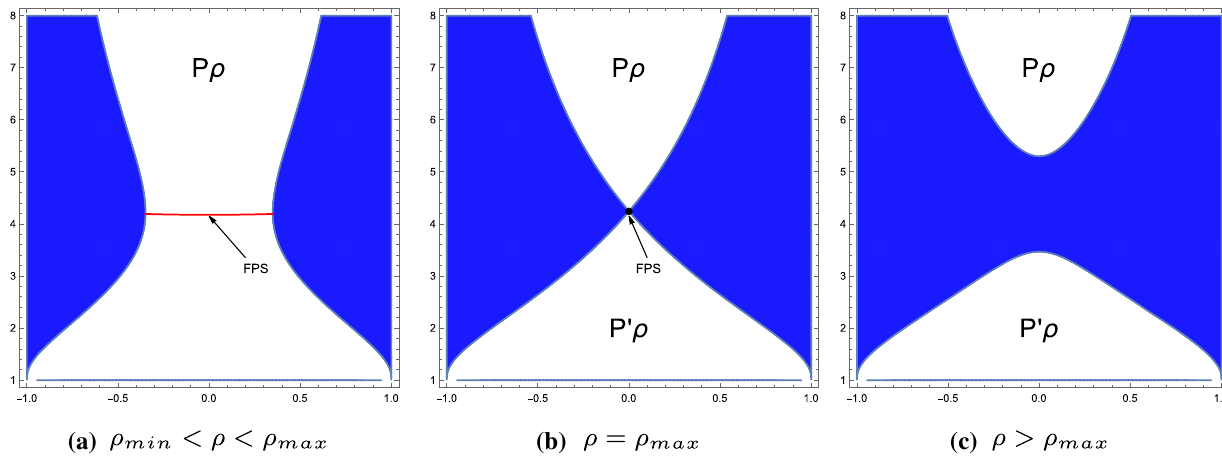
Fig. 1 Causal region in the Tomimatso–Sato